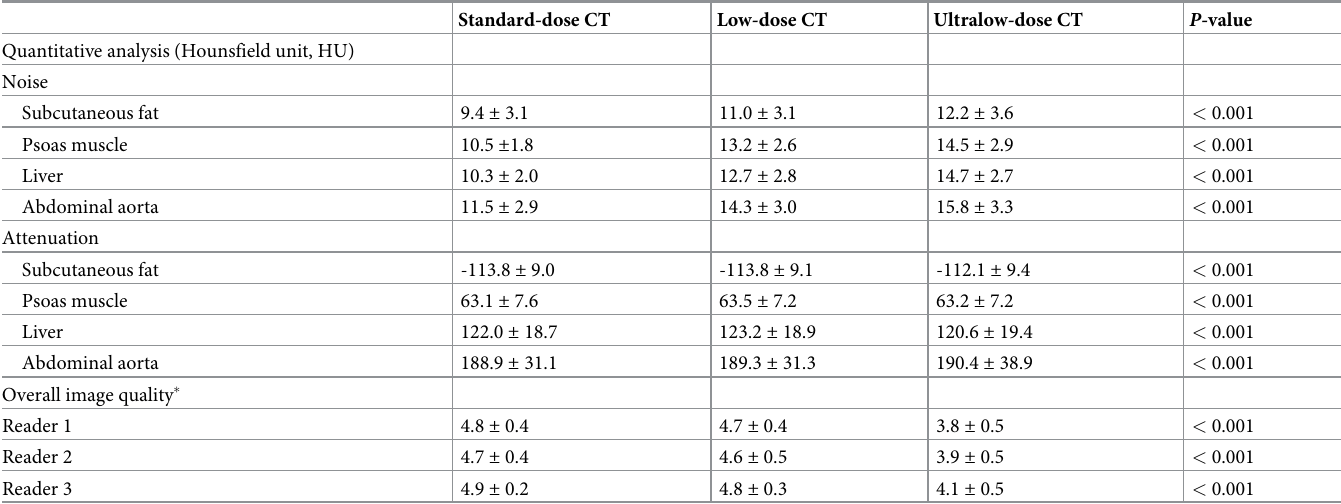
Table 5. Quantitative and qualitative image analysis of three CT image